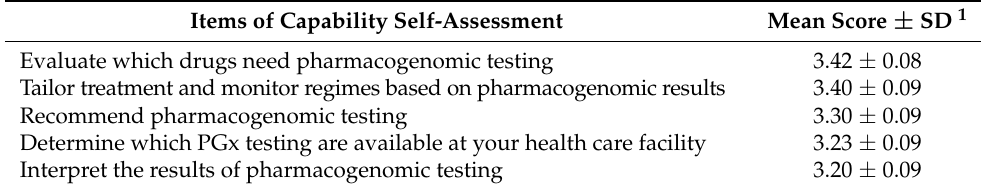
Table 2. Physicians’ confidence in personal capacity regarding PGx testing.